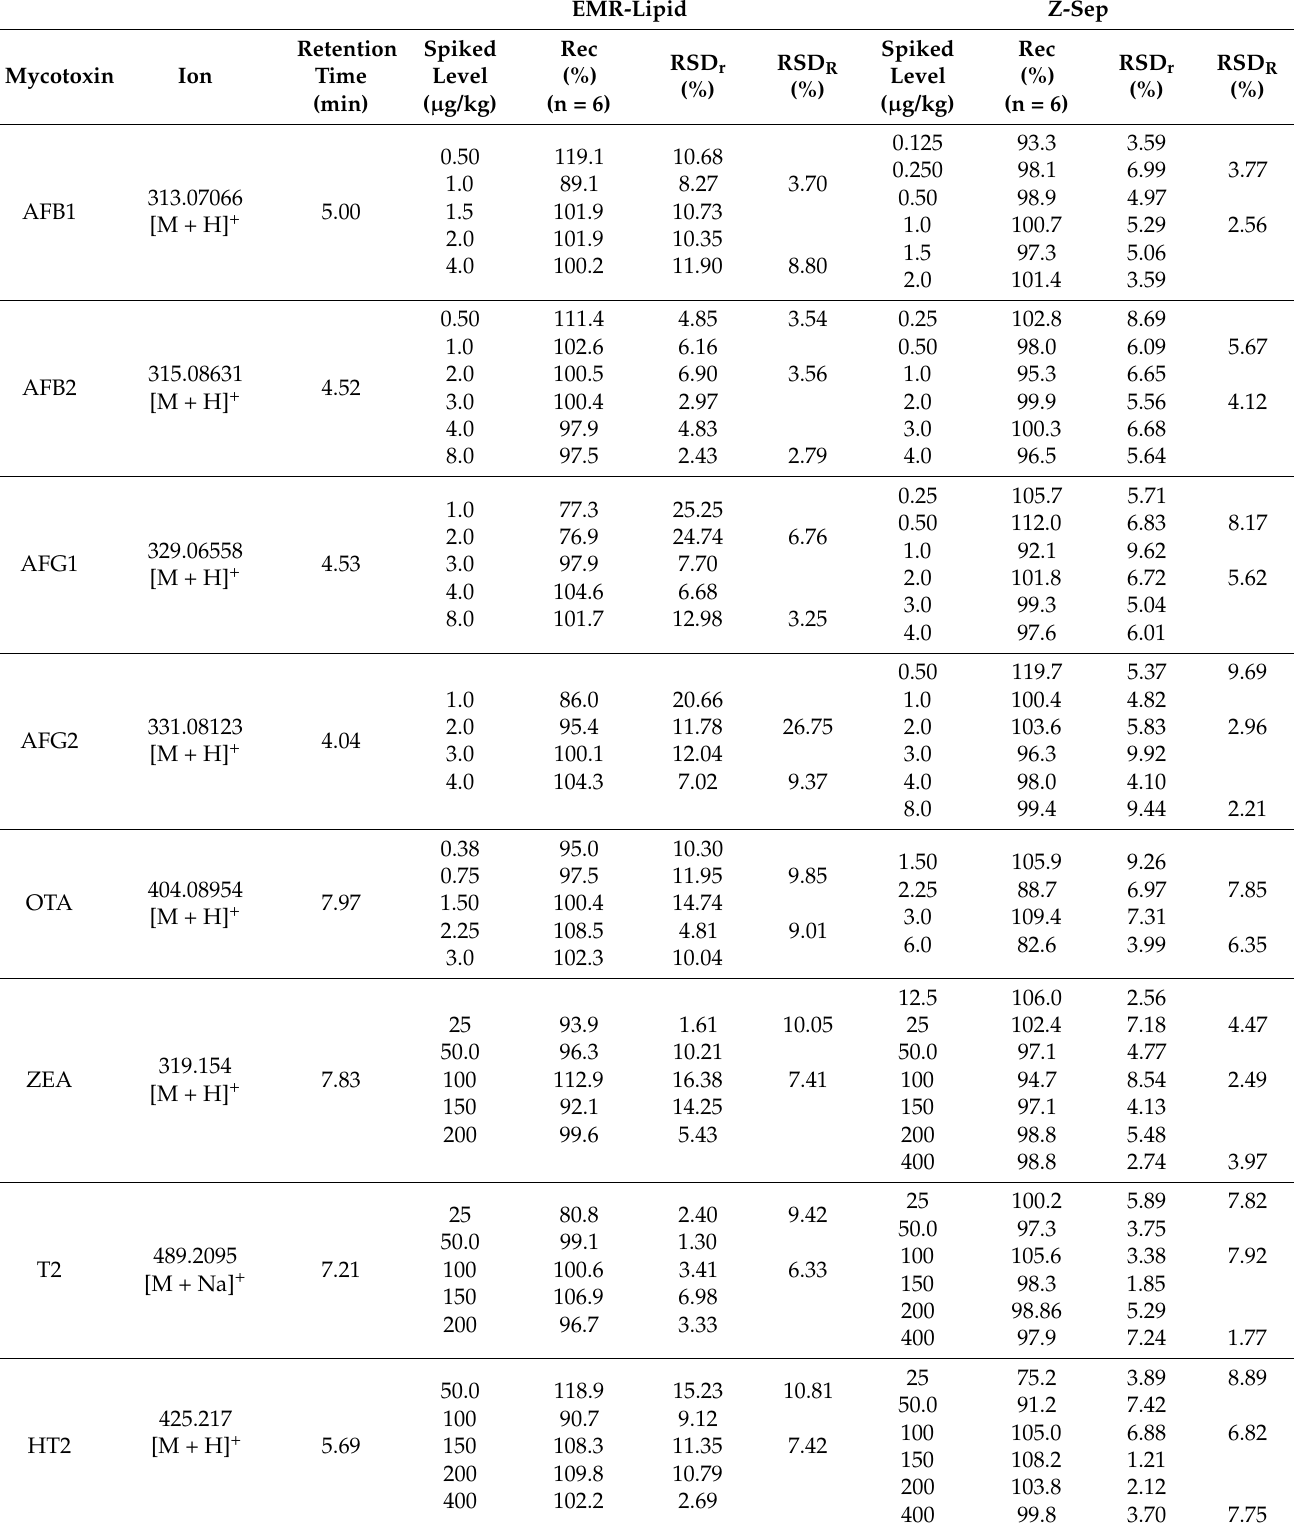
Table 2. Results of the validation for different mycotoxins, including recovery (Rec), relative standard deviation repeatability (RSDr) and relative standard deviation of precision inter-day (RSDR) at different spiking levels with enhanced